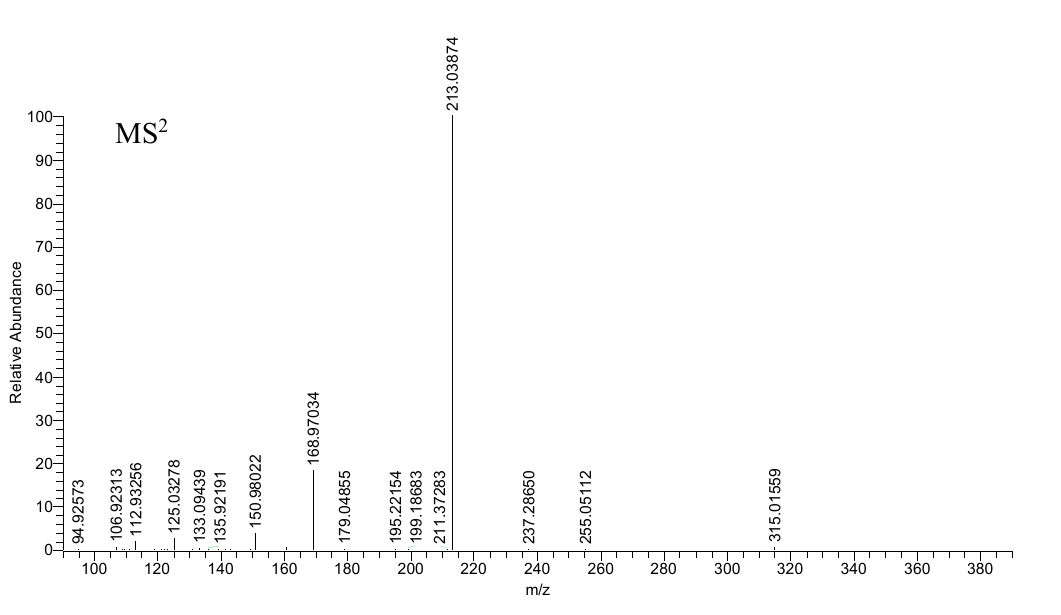
Figure 3. Spectra of ion fragments in MS n analysis of loganic acid in negative ion mode.